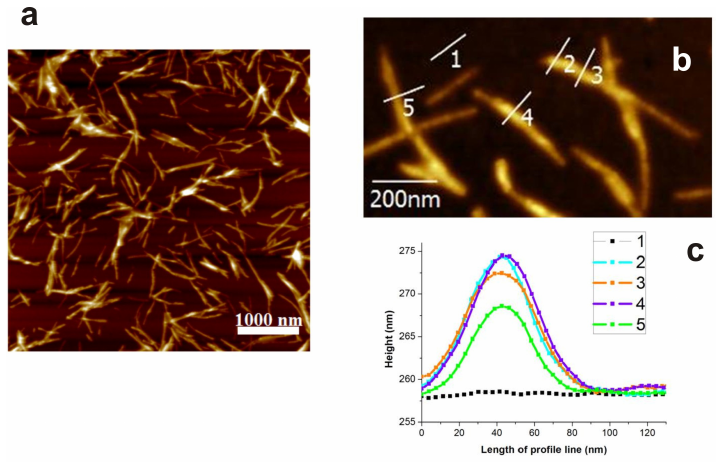
Figure 1. AFM images of ( a ) pure LAF and ( b ) a close-up view of the same sample in ( a ), and ( c ) topographical profiles of fibrillary thickness indicated in ( b ).